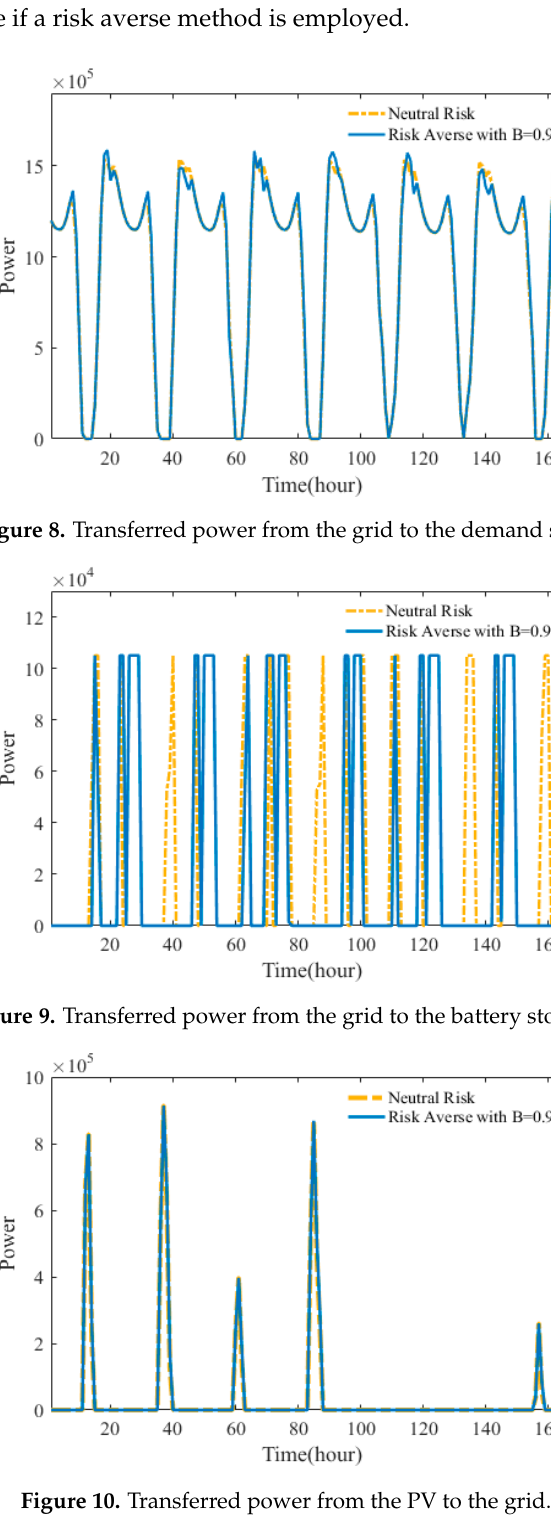
Figure 11. Transferred power from the PV to the storage. Figure 12. Transferred power from the storage to the demand side.